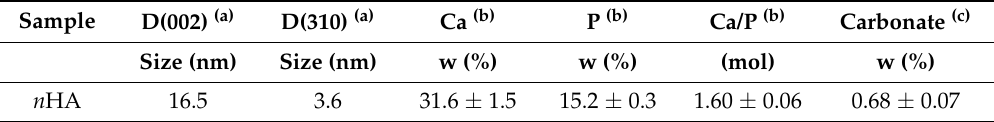
Table 1. Domain size as measured by PXRD (a) and chemical composition of n HA as determined by